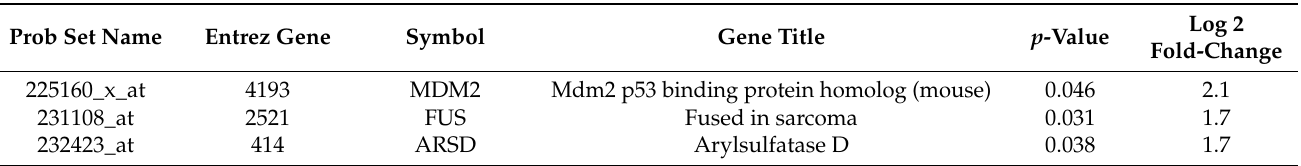
Table 1. List of top 20 genes based on fold change that were differentially expressed in HUVECs culture in 0.1 mM MgSO 4